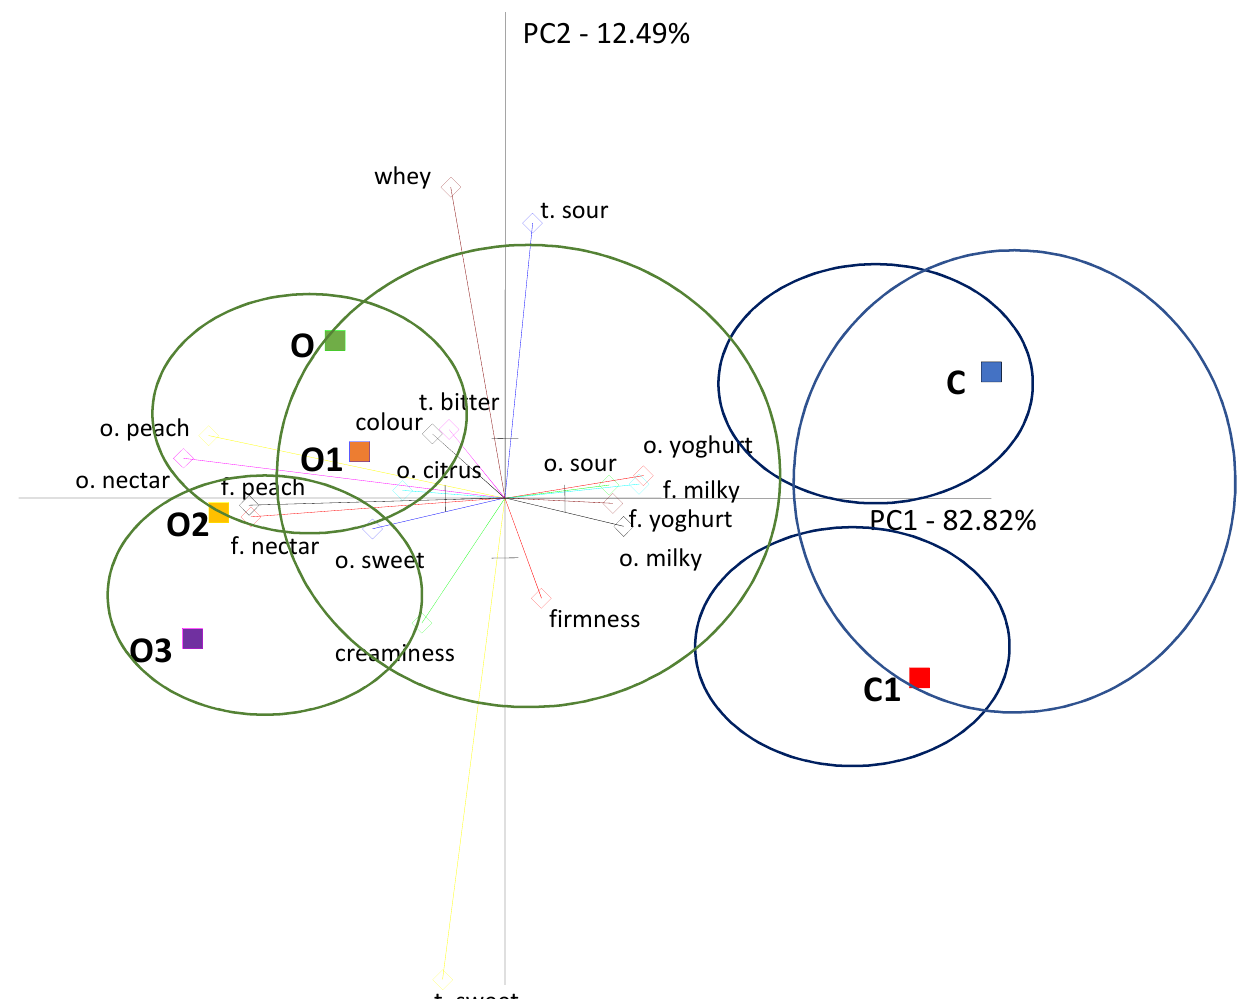
Figure 5. Principal Component Analysis (PCA) of the following yoghurt samples: C, control; C1, control with 6% inulin; O, oolong tea; O1, oolong tea with 3% inulin; O2, oolong tea with 6% inulin; O3, oolong tea with 9% inulin.